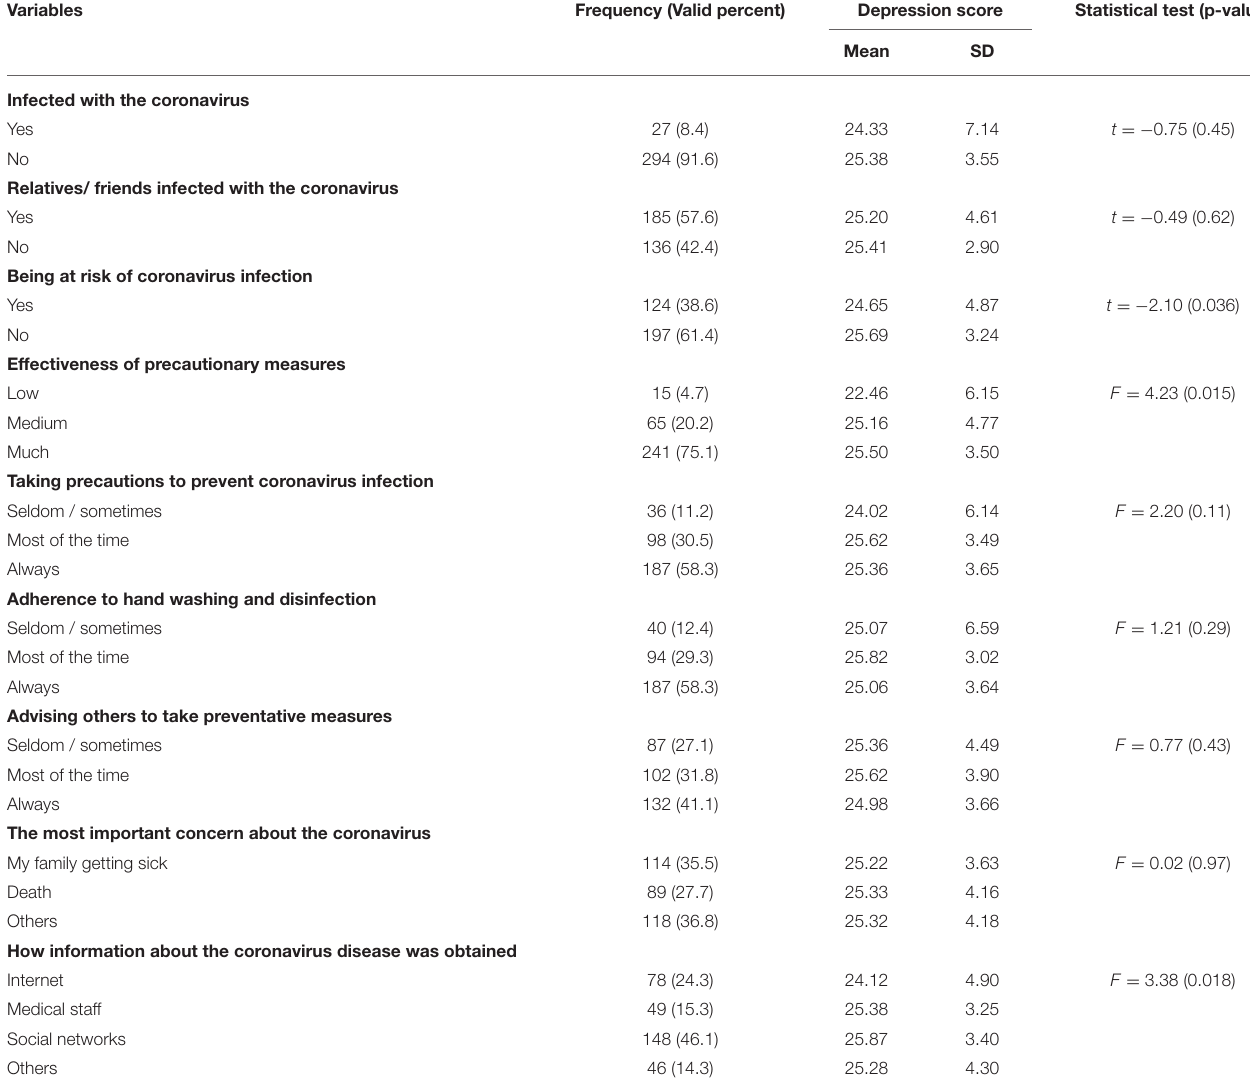
TABLE 2 | COVID-19 related variables and their associations with depression among children ( n = 321). Variables Frequency (Valid percent) Depression